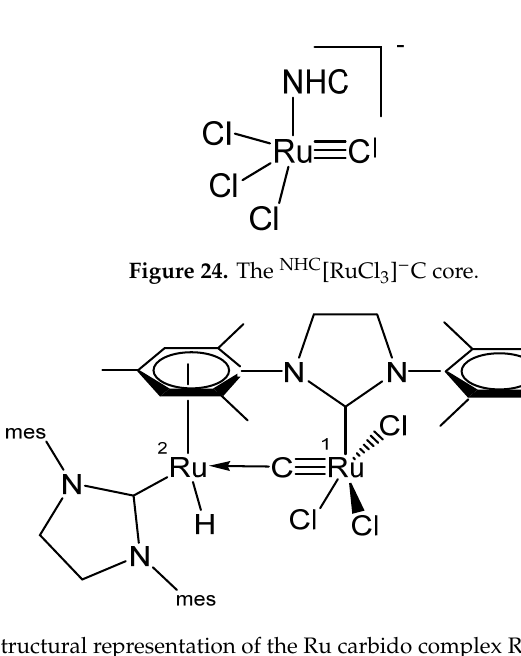
Figure 25. Structural representation of the Ru carbido complex Ru 2 (NHC) 2 ( ≡ C)Cl 3 H.